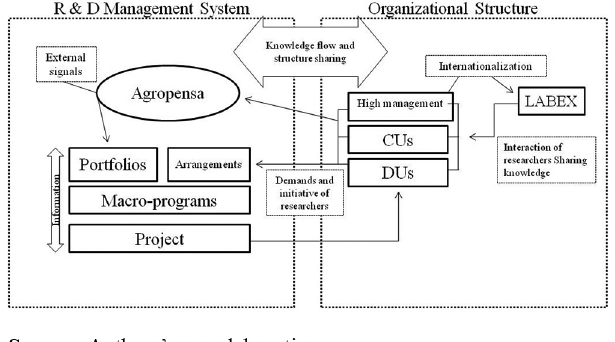
Figure 3. Descriptive model